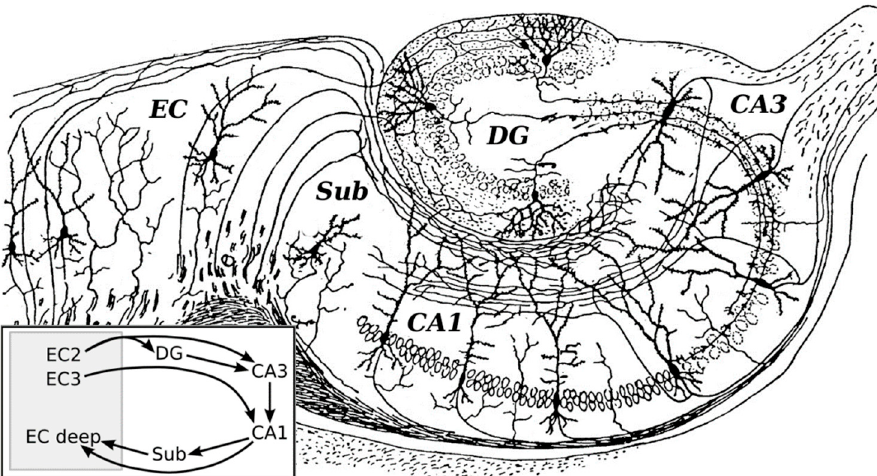
Figure 1. Organization of the hippocampal formation as originally drawn by Ramon y Cajal (1911) with a schematic representation of the layer organization. The trisynaptic circuit in the hippocampus is organised into three main regions: the dentate gyrus, the CA3, and CA1 fields. The perforant pathway connects the entorhinal cortex with the dentate gyrus and was the original site of study for long-term potentiation (LTP). Mossy fibers from the dentate gyrus project to the CA3 field. From CA3 fields, fibers may exit via the fornix (upper right) or continue to the CA1 via the Schaffer collateral pathway. The CA1 neurons then project onto other neurons in the entorhinal cortex and subiculum. EC = entorhinal cortex; CA = cornu ammonis; DG = dentate gyrus; Sub = subiculum. Modified image (rotated, relabelled, additional diagram in Gi) obtained from Wikimedia Commons Public Domain search [11].